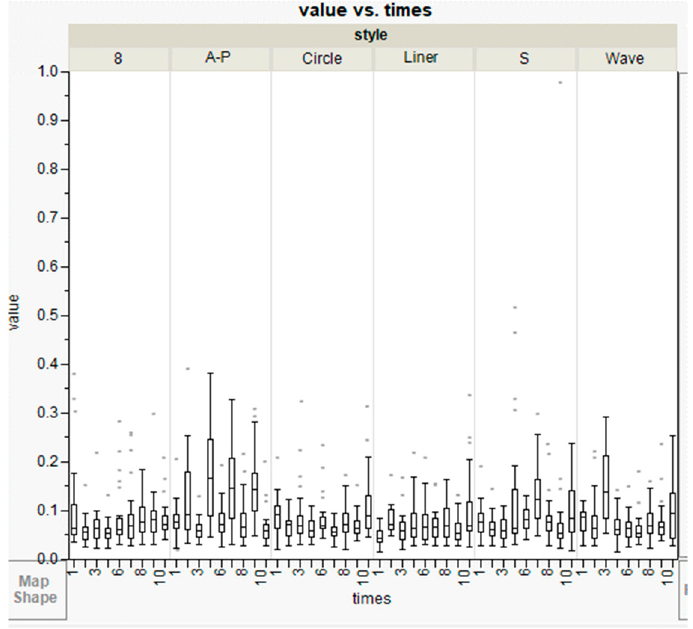
Figure 9. The box plot shows the repetitive deviation of the six head movements in 10 scans. All movements showed similar precision in the